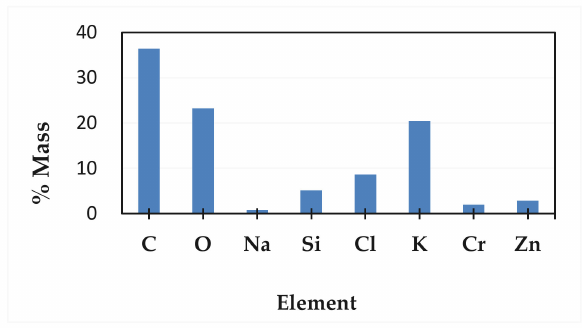
Figure 20. Chemical content analysis of ZnCr 2 O 4 composite by EDX.